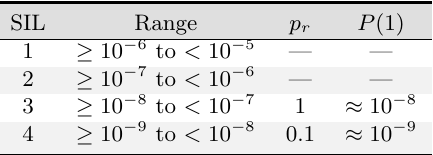
Table 1: The IEC 61 508 Safety Integrity Levels for the Single Spike